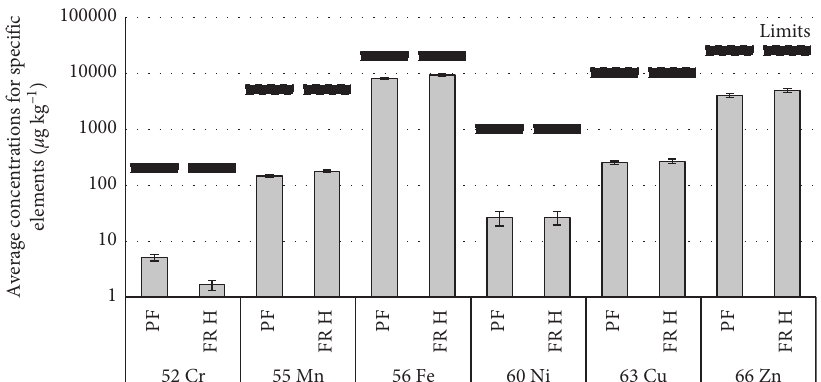
Figure 2: Estimated daily intake ( μ g kg − 1 /g/day) of Cr, Mn, Fe, Ni, Cu, and Zn from hen eggs according to the FAO/WHO provisional tolerated daily intake. PF, poultry farms; FR H, free-range hens.